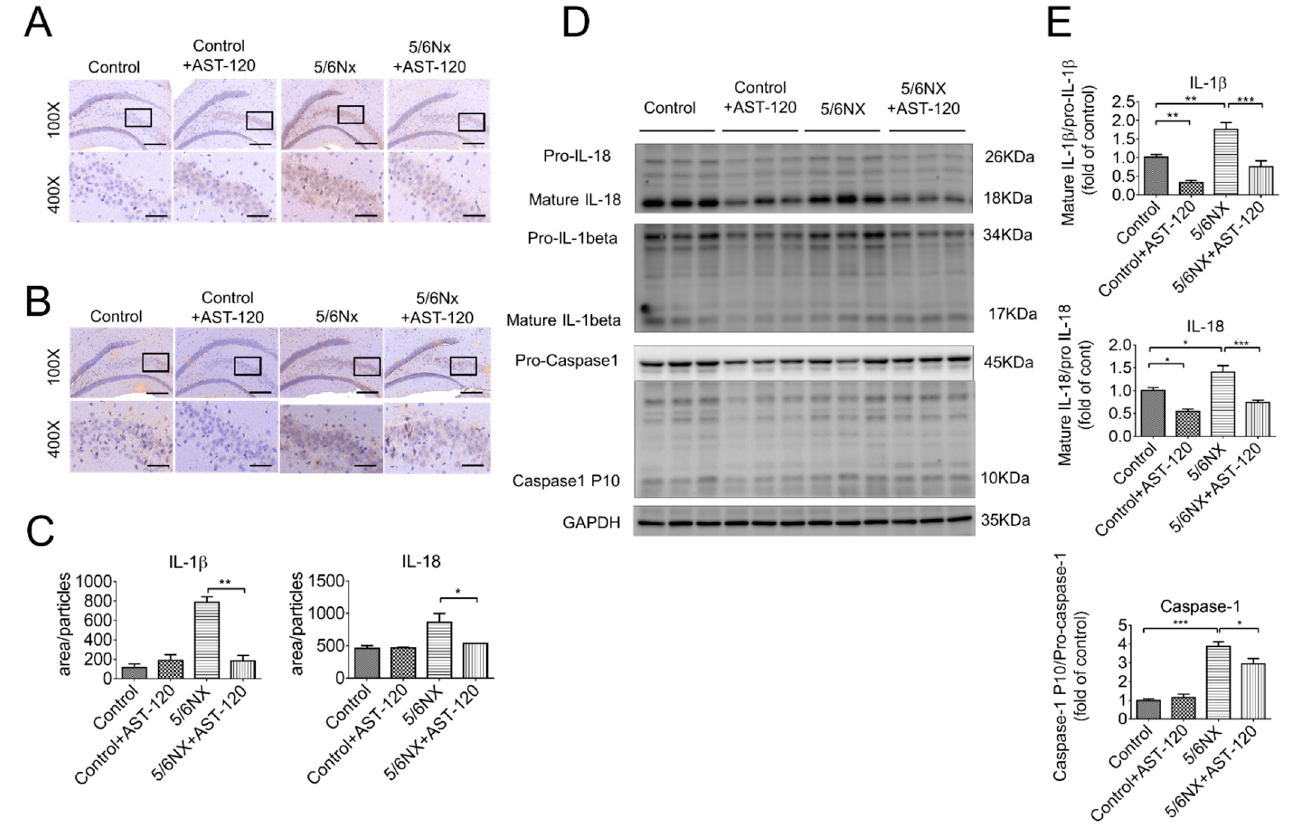
Figure 6. Hippocampal inflammation in CKD mice was effectively suppressed by AST-120 administration. Immunohis- tochemistry staining against IL-1 β and IL-18 was used to examine hippocampal inflammation. There was significantly increased IL-1 β (panel ( A )) and IL-18 (panel ( B )) expression in the hippocampal of CKD mice, which was effectively suppressed by AST-120 administration (panel ( C )). Similarly, the Western blotting assay revealed increased IL-1 β , IL-18, and caspase-1 expression in the hippocampus of CKD mice, which was reverted by AST-120 administration (panel ( D , E )). The results suggested that decreased IS levels could ameliorate hippocampal inflammation. (Scale bar 100×: 200 μ m, 400×: 50 μ m, * p ≤ 0.1; ** p ≤ 0.01; *** p ≤ 0.00; n = 3 for immunohistochemistry, 6 images were taken from each animal; n = 6 for Western blotting).